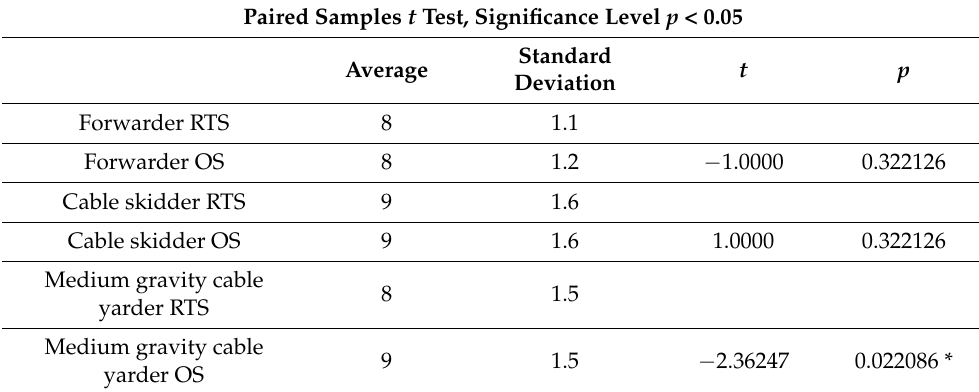
Table 5. Paired samples t test results. * indicates statistically significant differences ( p < 0.05). Paired Samples t Test, Significance Level p <